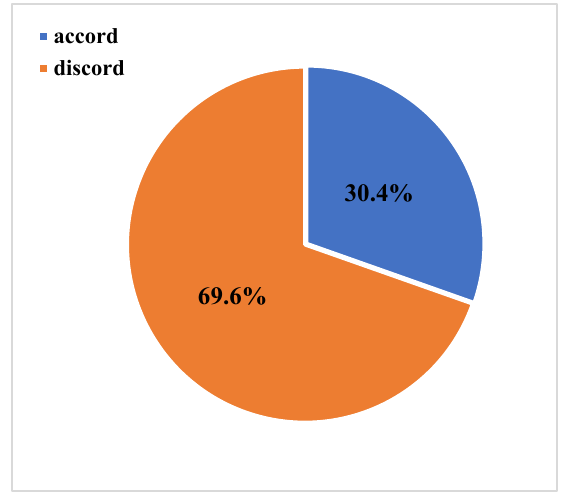
Figure 2. Rate of consistency between experts and management staff .